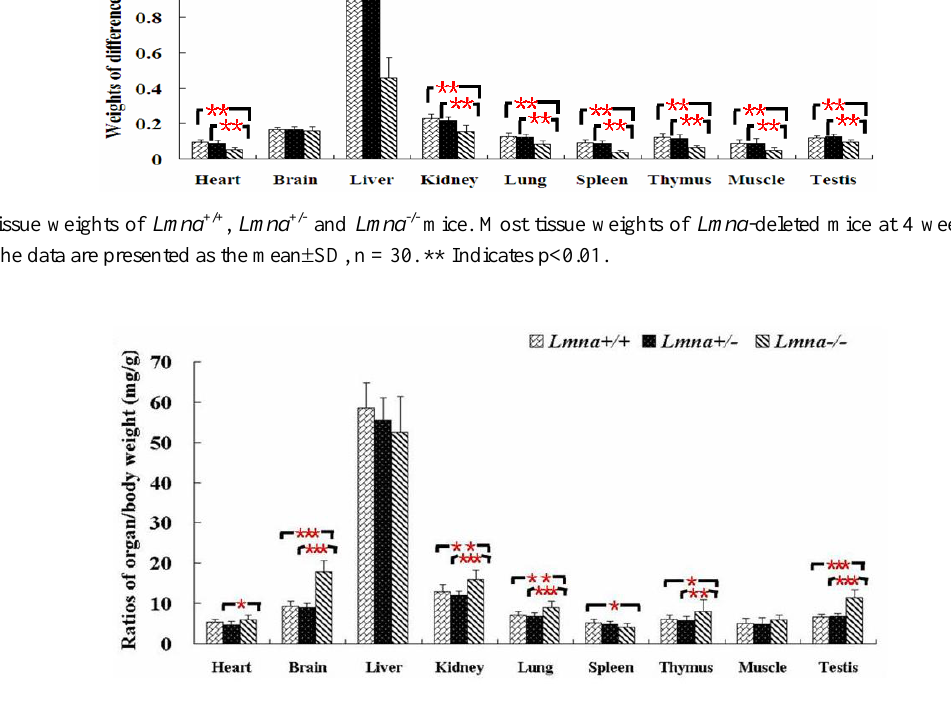
Figure 4. The ratio of organ to body weight in Lmna +/+ , Lmna +/- and Lmna -/- mice. Lmna -/- mice at 4 weeks displayed increased ratio of organ to body weight in most of tissues. The data are presented as the mean  SD, n = 30. * Indicates p<0.05; ** Indicates p<0.01; *** Indicates